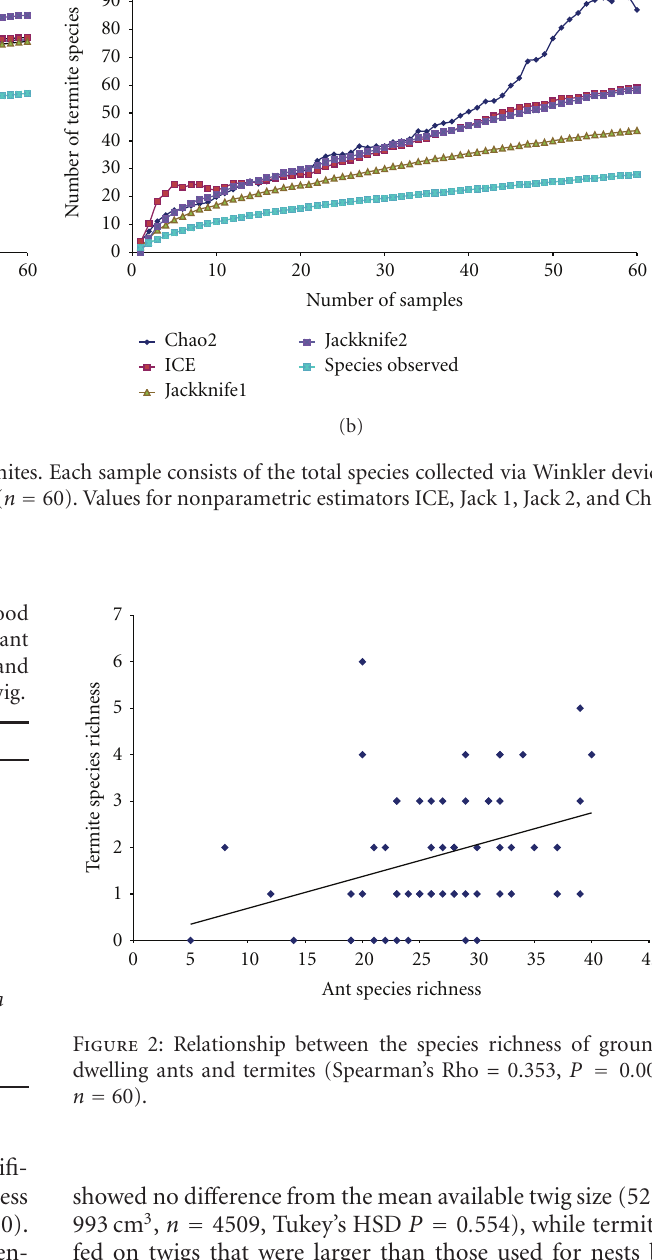
showed no di ff erence from the mean available twig size (52 ± 993 cm 3 , n = 4509, Tukey’s HSD P = 0 . 554), while termites fed on twigs that were larger than those used for nests by ants (365 ± 915 cm 3 , n = 138, P = 0 . 022) and larger than twigs of average available size ( P = 0 . 001). Conversely, mean decay of twigs utilized by termites (3.47 ± 0.852) did